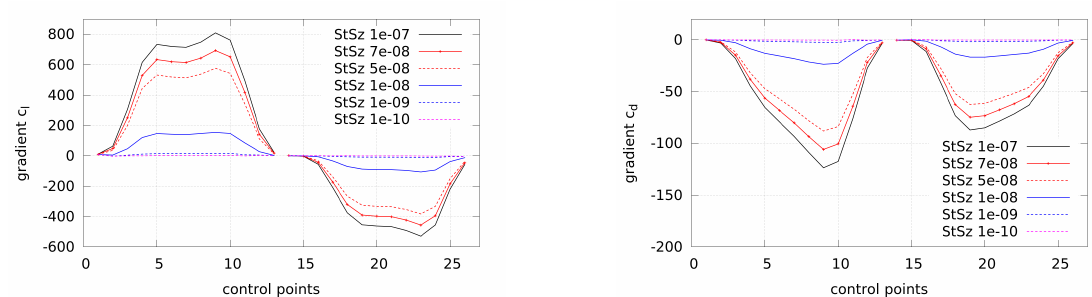
Figure A2. Gradients obtained by finite differences (FDs) for lift objective (“gradient c l ”) and drag objective (“gradient c d ”). Different step sizes (StSz) are used for finite